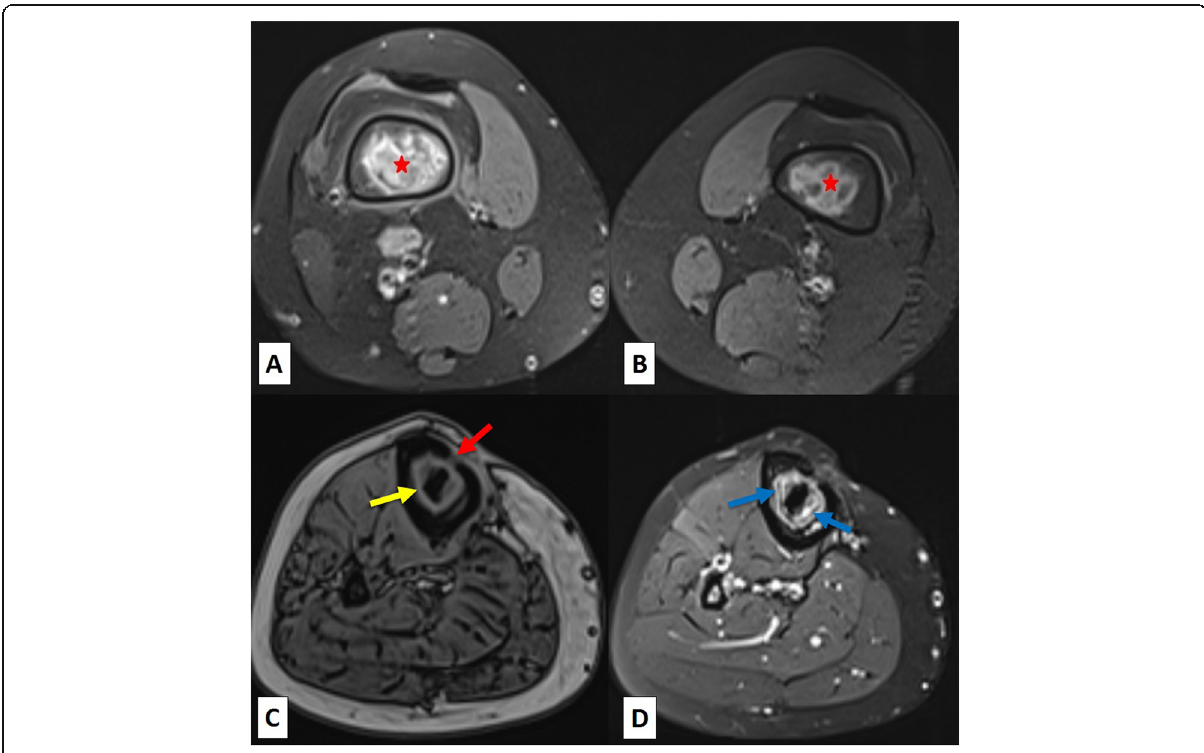
Fig. 4 Axial non-enhanced T1fs a and b through the lower femurs in 19-year-old male patient with bilateral acute thigh pain show bilateral focal bone marrow hyperintensity involving the right more than the left lower femoral shaft; features of acute marrow infarcts. Axial OP c and post- contrast T1fs d through the right upper tibial shaft on the same patient show focal intra-medullary hypointense sequestrum (yellow arrow), focal cortical interruption (red arrow), and non-homogenous marrow enhancement (blue arrows); features are consistent with chronic